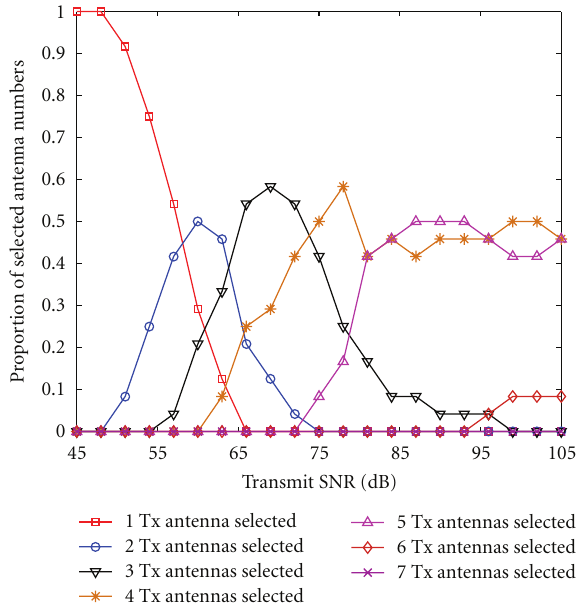
Figure 5: The antenna number of optimal TAS subset.